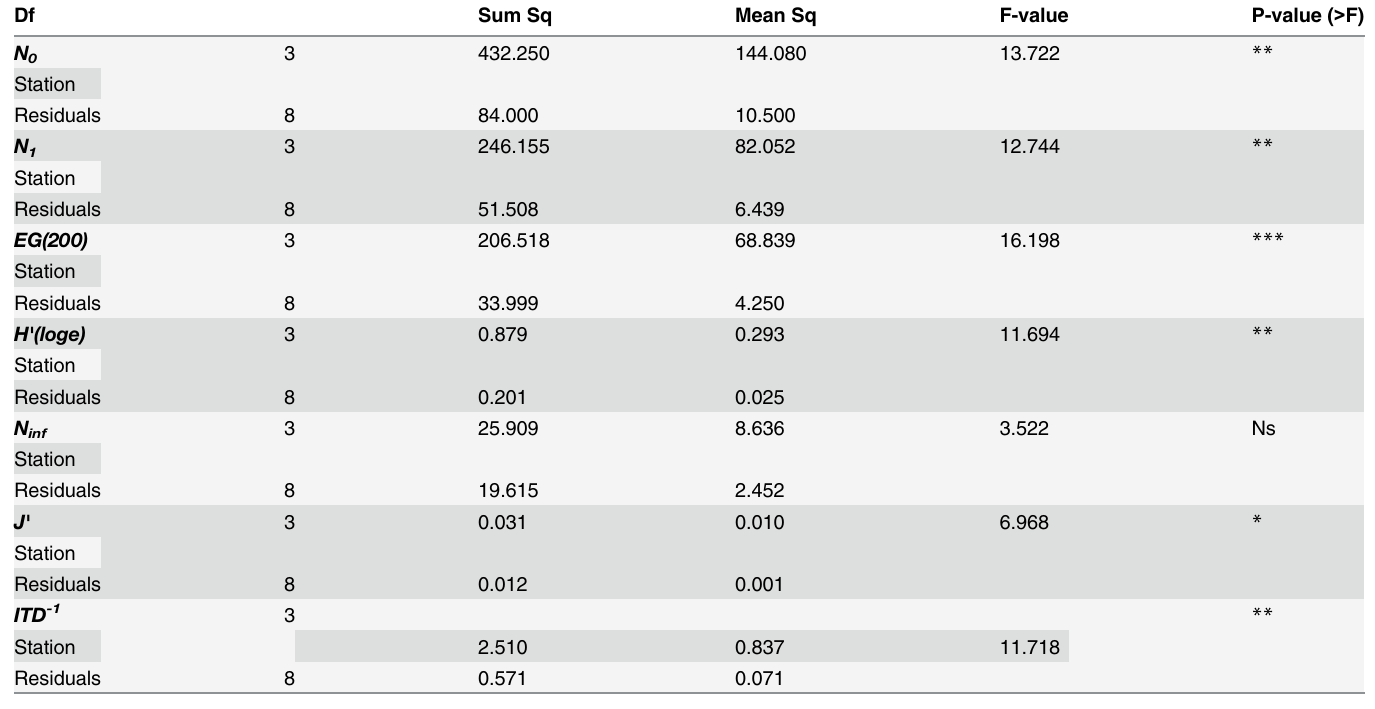
Table 7. One-way ANOVA results for each index with their P-values. Df Sum